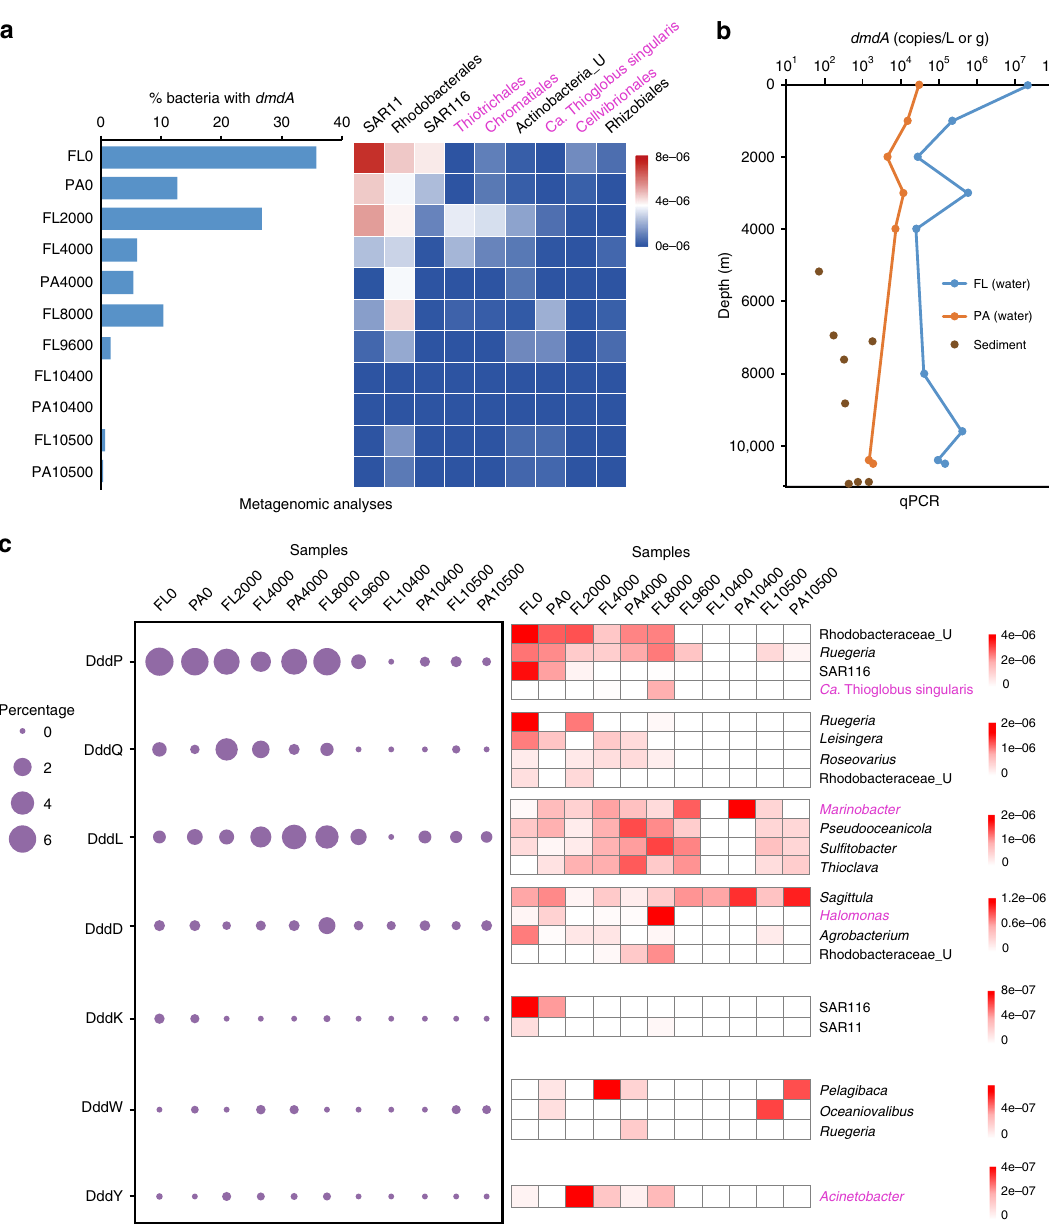
Fig. 3 The abundance of DMSP catabolic genes in Challenger Deep water samples. a The relative abundance of bacterial cells containing the DMSP demethylation gene dmdA at different depths (left), with the top nine af fi liated orders containing them shown in the heat map (right). Genera belonging to Gammaproteobacteria are labeled in pink; those in black font are Alphaproteobacteria or Actinobacteria . b Absolute abundance of dmdA in the seawater and sediment at various depths, as determined by qPCR. c The relative abundance of bacterial cells containing DMSP cleavage genes at different depths (left) with the top four af fi liated genera of each gene shown in the heat map (right). Genera belonging to Gammaproteobacteria are labeled in pink; those in black font are Alphaproteobacteria . FL: free-living; PA: